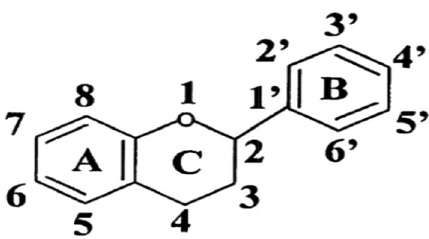
Fig. 5 Basic nuclear structure of flavonoids. Source: [42]. Pharmacological activities of flavonoids and their metabolites in vitro depend upon the arrangement of functional groups about the nuclear